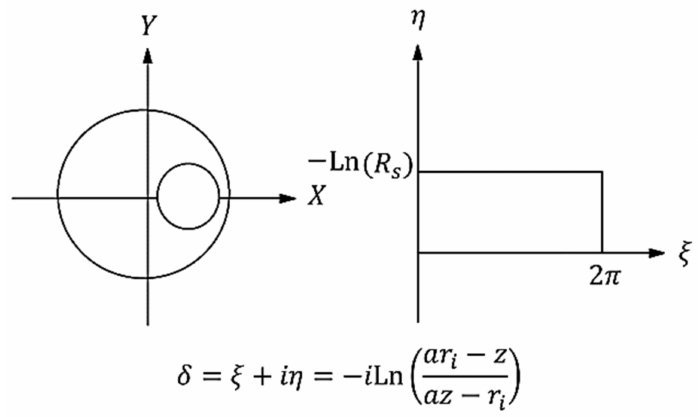
Figure 3. Mapping to transform physical domain to computational